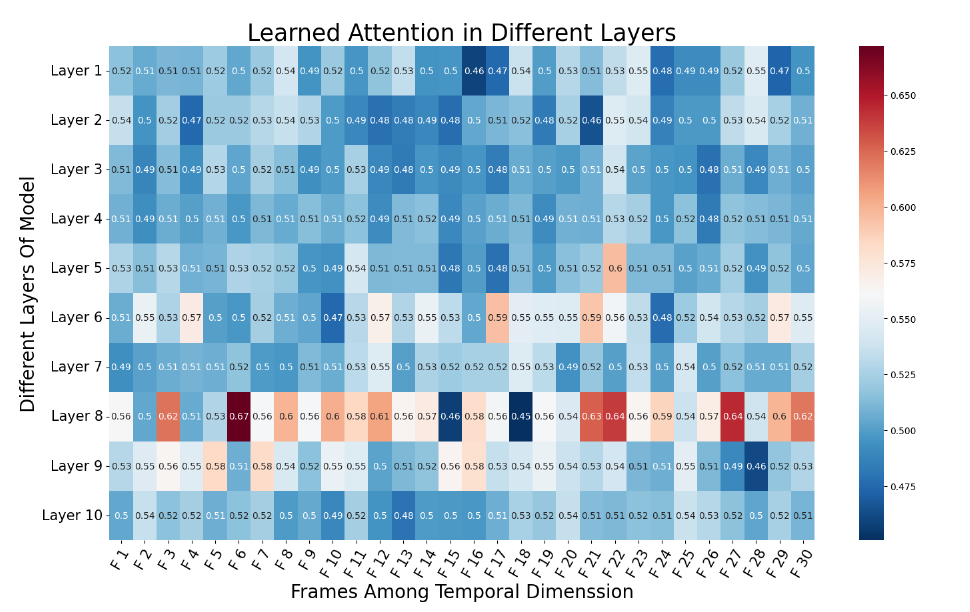
Figure 5. Visualization of learned attention by CTRGCN paired with TE-TAMs in different layers. We only show thirty frames of the first data sample in TestSet 3